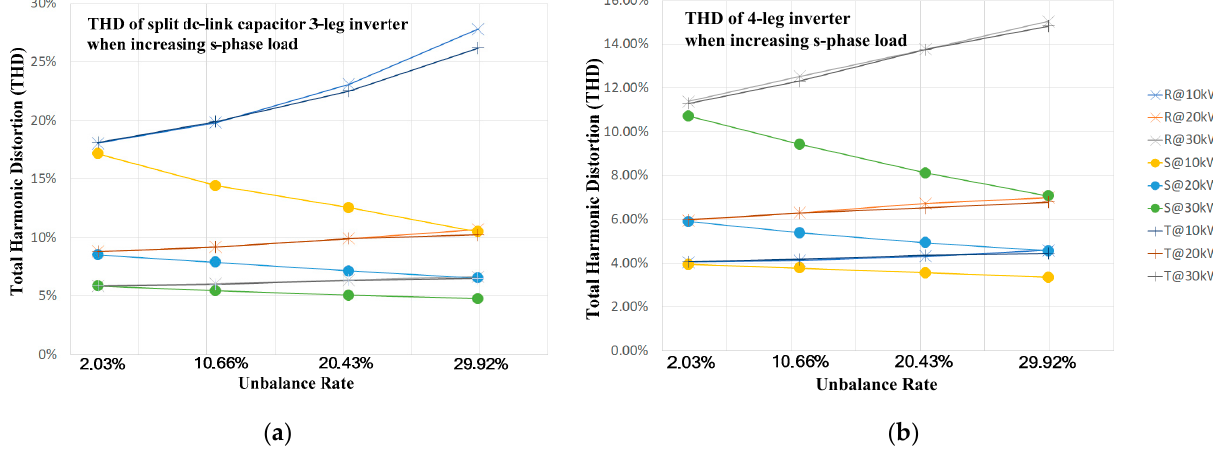
Figure 8. Comparison of THD of the inverter output current when the inverter compensates for load imbalance due to the increase in the s-phase load with a constant output: ( a ) split dc-link capacitor 3-leg inverter; ( b ) 4-leg inverter.